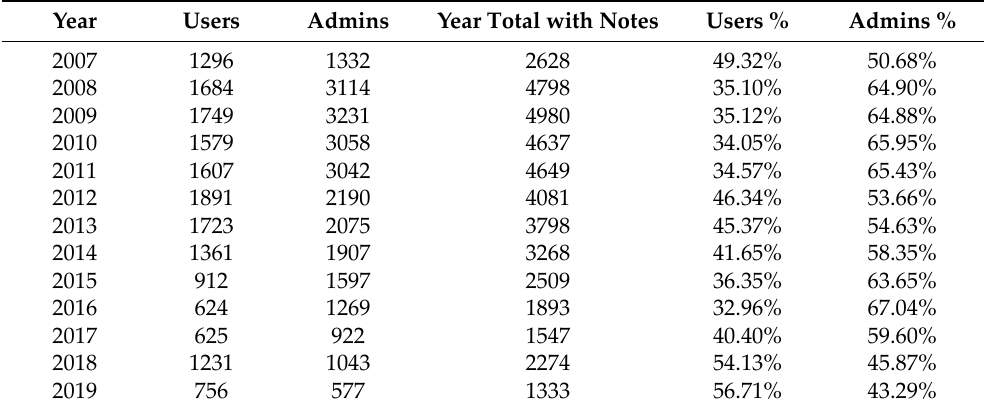
Table A4. Breakdown by Year of Questions Where Users Specified Who Should Answer, and Ques‑ tions Assigned by an